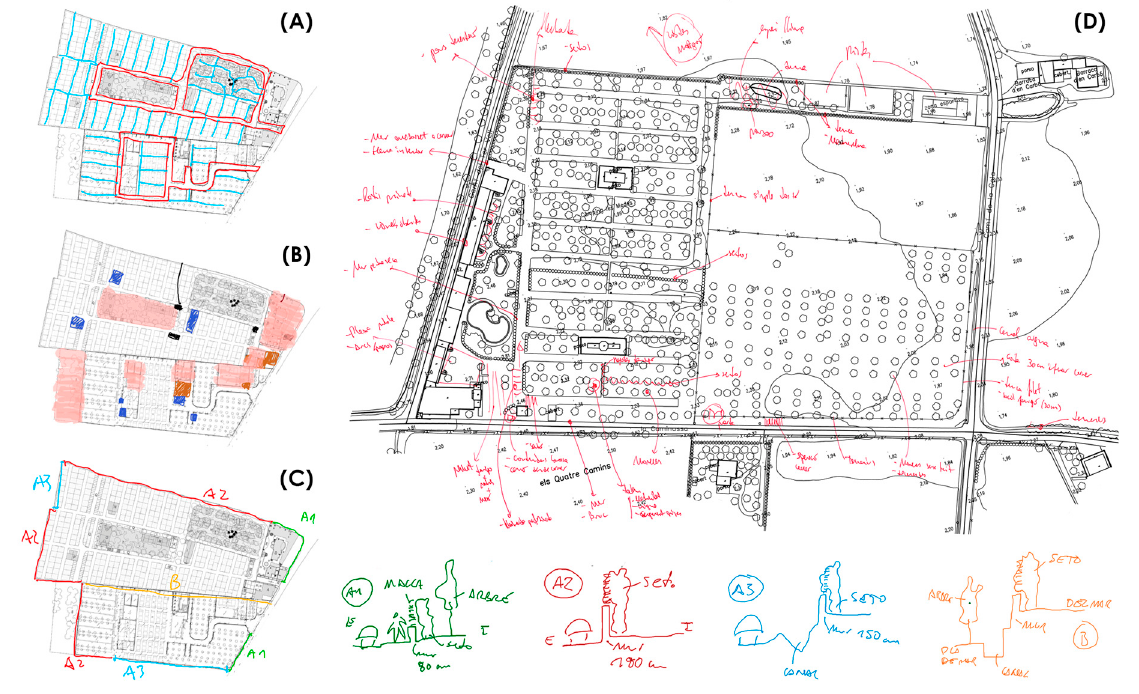
Figure 4. Sample of schemes and diagrams made in the fieldwork during on-site data collection (Source: authors’ own). ( A ) Road hierarchy (PM); ( B ) Buildings and open spaces (PM); ( C ) Boundaries in ground floor and section (PM); ( D ) Reading of the place